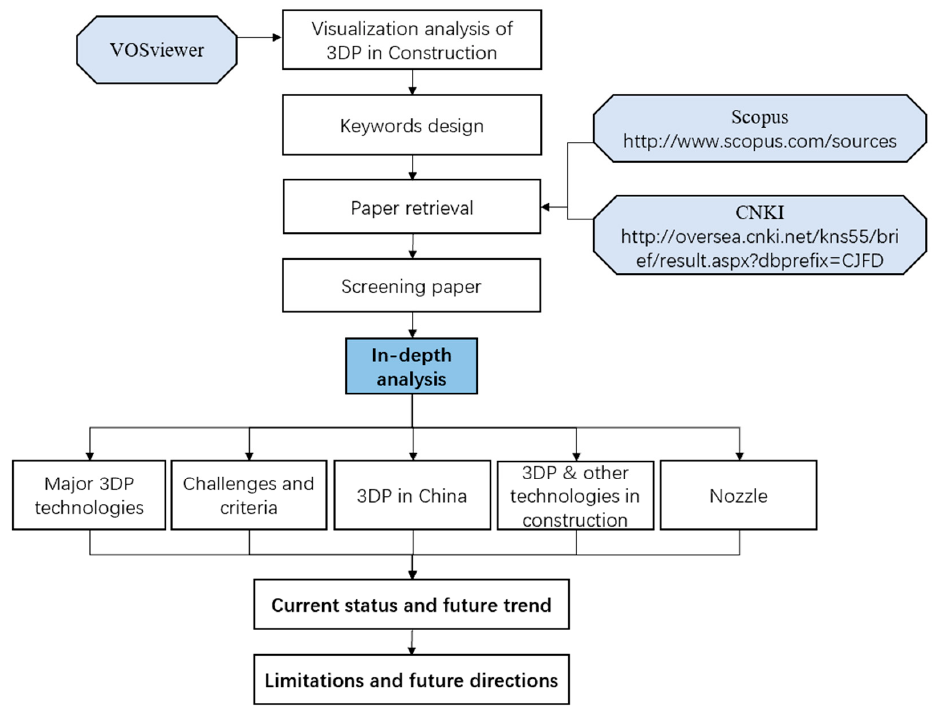
Figure 1. Research flowchart, including the main tasks of the present systematic review process.